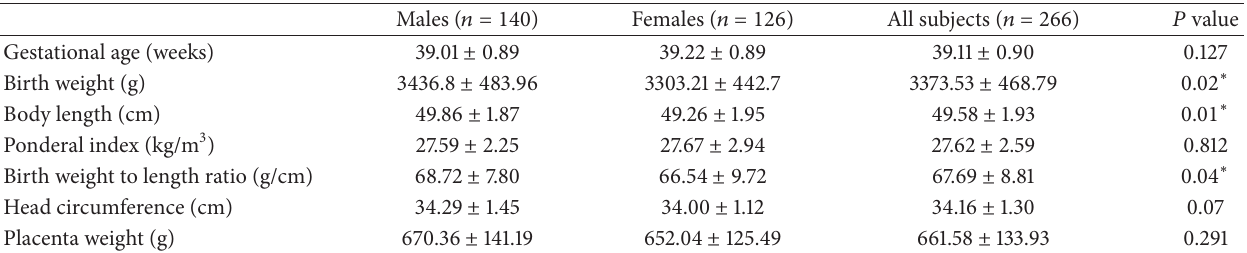
Table 1: Clinical characteristics and anthropometric measurements of